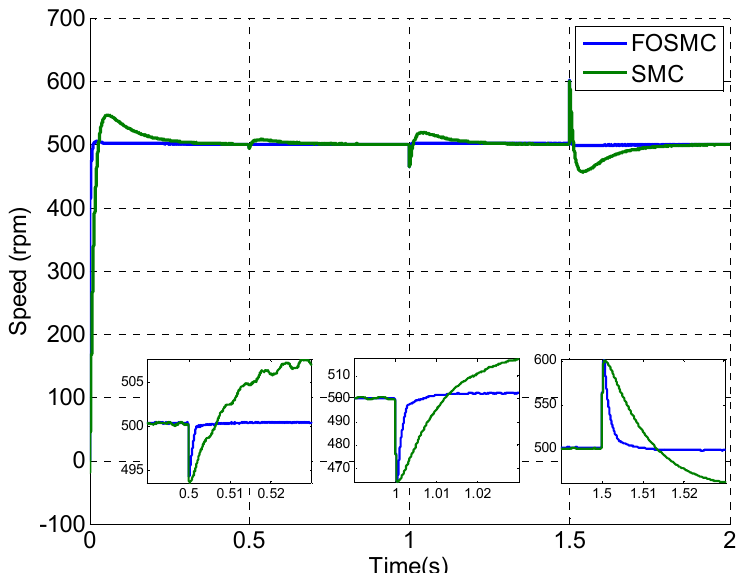
Figure 9. Speed response of FOSMC-PID speed controller for motor sizes.